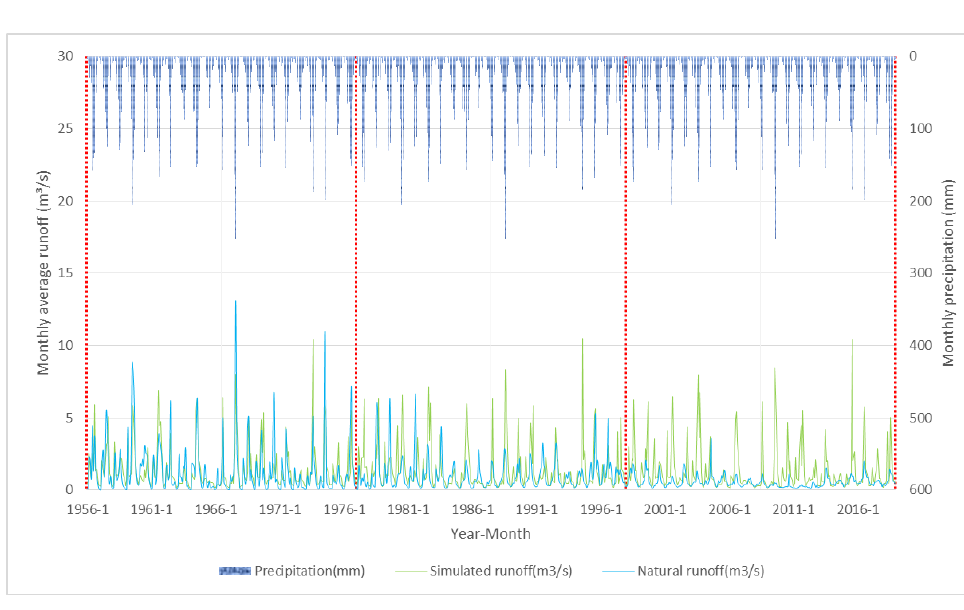
Figure 10. Simulated results of S1 (CCS).